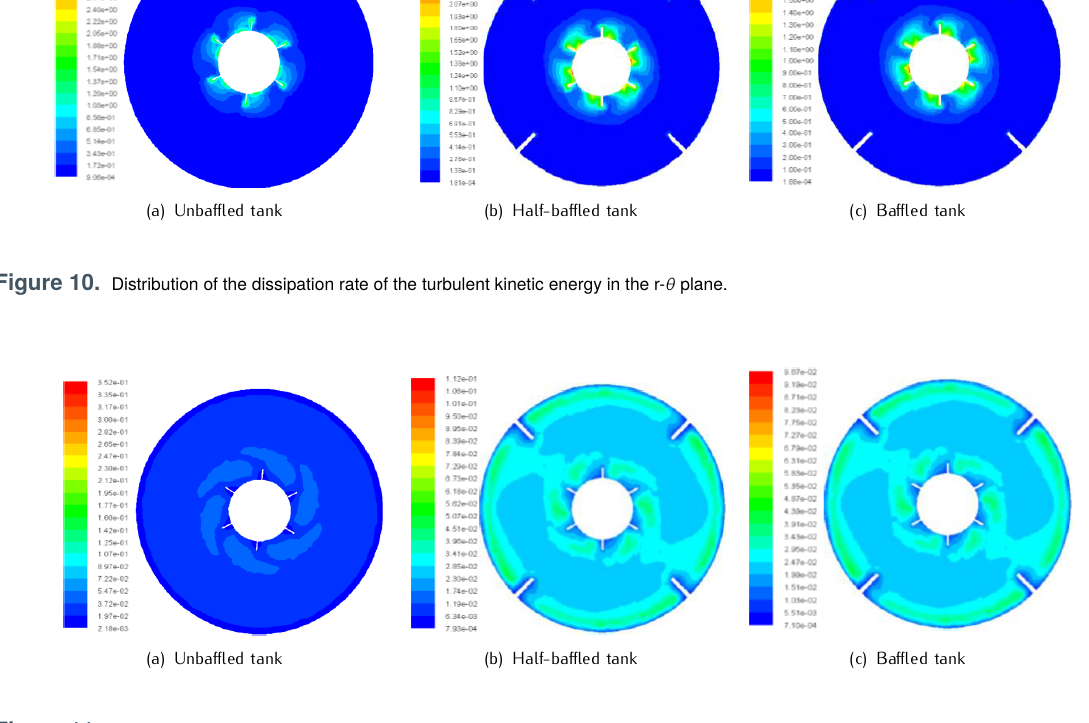
Figure 11. Distribution of the turbulent viscosity in the r- θ